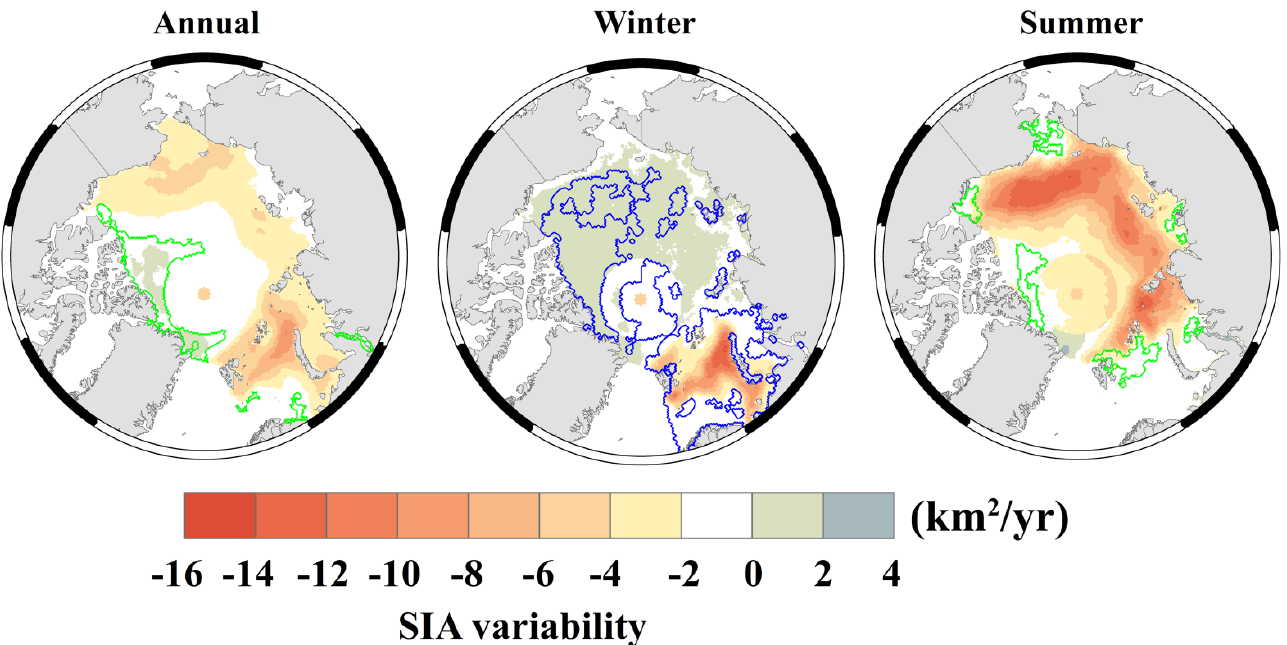
Figure 5. The SIA trend maps from 1979 to 2020. The blue contour lines denote that these trends are significant at the 95% significance level and the green contour lines denote that these trends are insignificant at the 95% significance level.